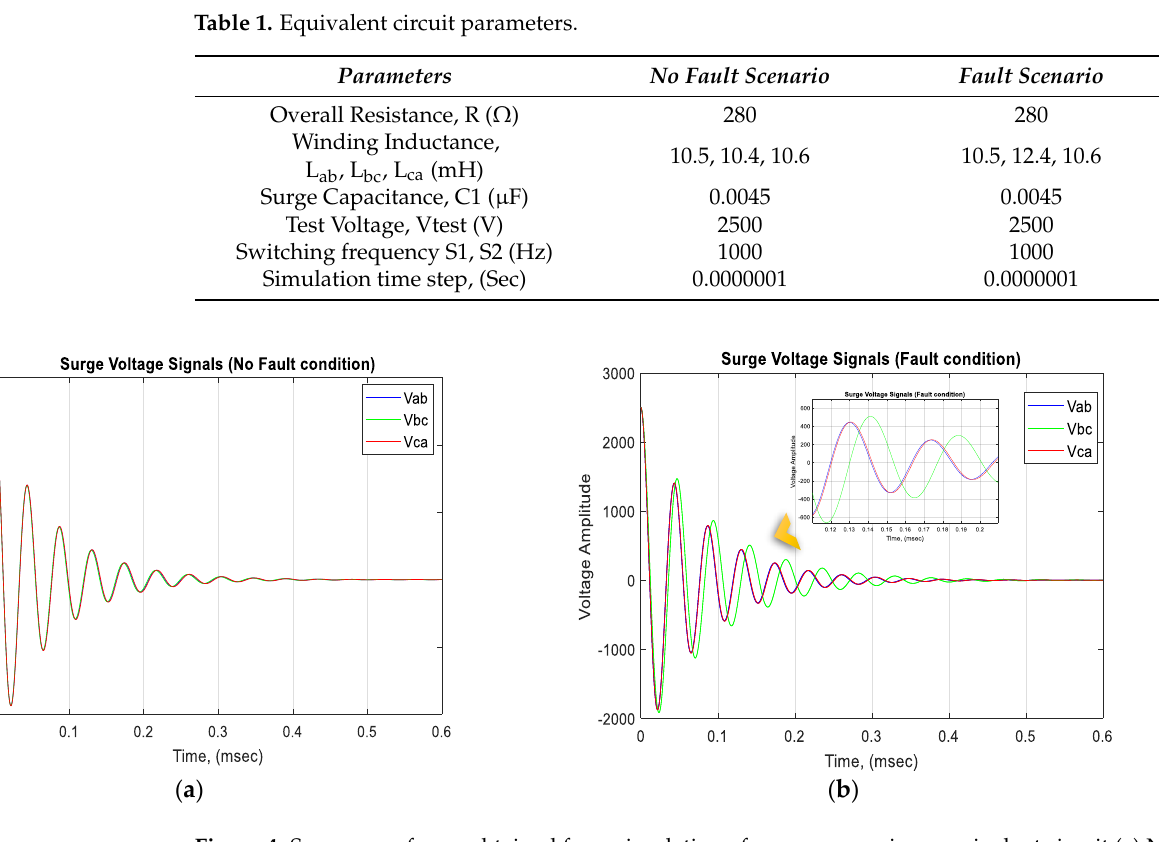
Figure 4. Surge waveforms obtained from simulation of surge comparison equivalent circuit ( a ) No fault ( b ) Fault.